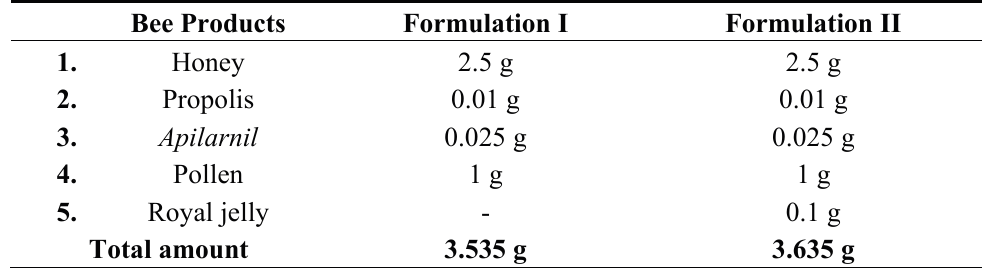
Table 9. The daily intake of the two apitherapy diet formulations calculated for 100 g